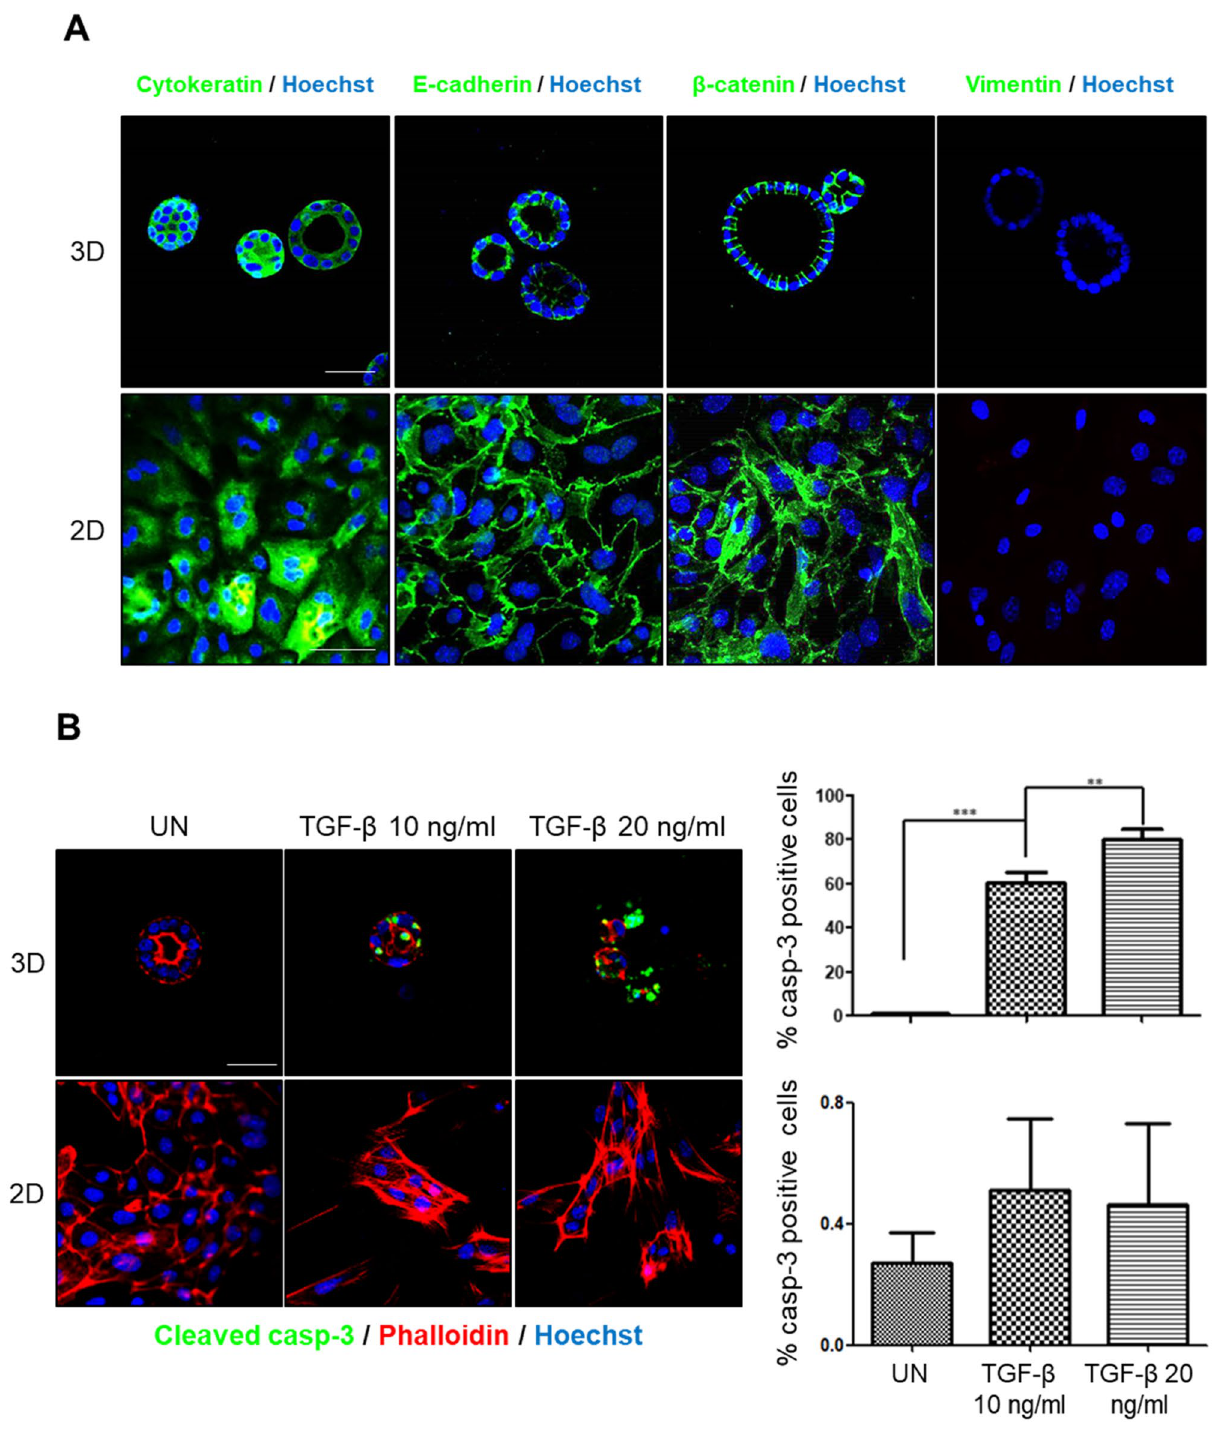
Figure 1. ( A ) Cytokeratin, E-cadherin, β-catenin and vimentin immunofluorescence on epithelial endometrial cells grown as 2D monolayers or 3D organoids show no differences in epithelial markers expression. Cells were counterstained with Hoechst to visualize nuclei. Scale bars: 25 µm. ( B ) Confocal images and quantification of cleaved caspase-3 immunofluorescence on endometrial cells grown as 2D monolayers or 3D organoids untreated (UN) or treated with 10 or 20 ng/ml TGF-β for 72 h. Cells were counterstained with phalloidin to visualize actin cytoskeleton and morphology and Hoechst to visualize nuclei. Scale bars: 25 µm. Values are mean and error bars represent mean ± S.E.M. ** P < 0.01; *** P < 0.001 by one-way ANOVA, followed by the Tukey’s multiple comparison